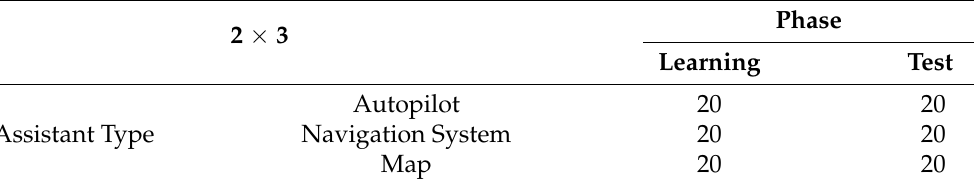
Table 1. Experimental design: experimental conditions with the total sample